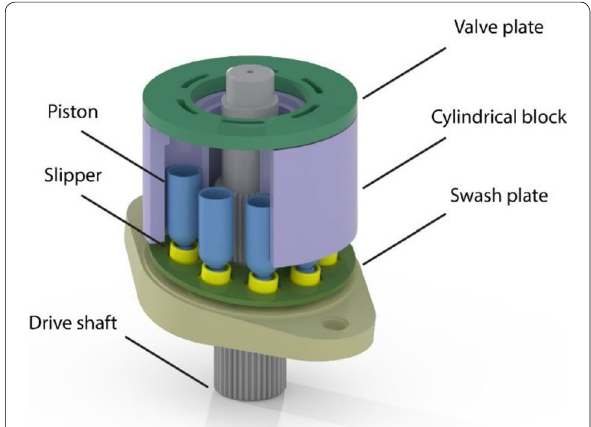
Figure 1 Axial piston pump